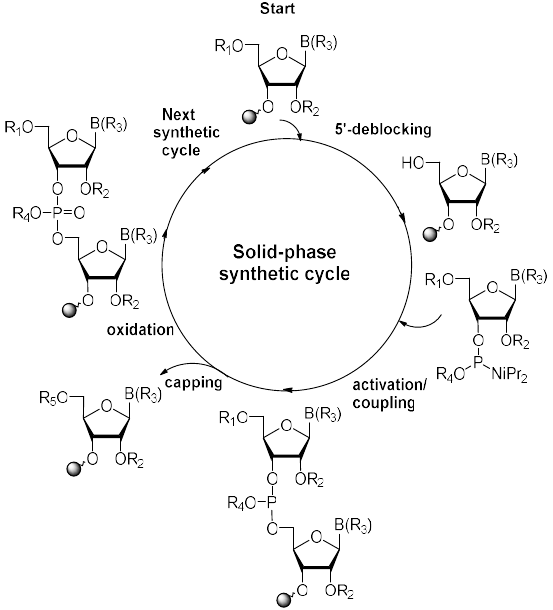
Scheme 1. General scheme of RNA solid-phase synthetic cycle. R 1, R 2 , R 4 : protecting groups for 5 (cid:48) -OH, 2 (cid:48) -OH, and phosphate residue, respectively; B(R 3 ): protected nucleobase; R 5 : capping